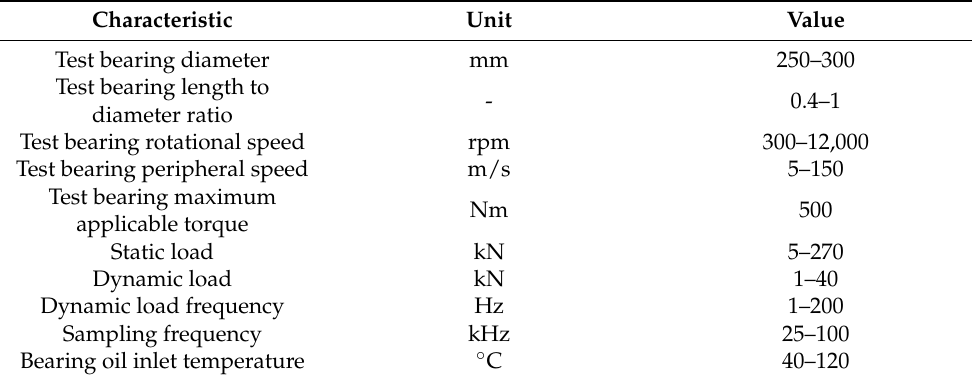
Table 3. Characteristics of the test rig in the present